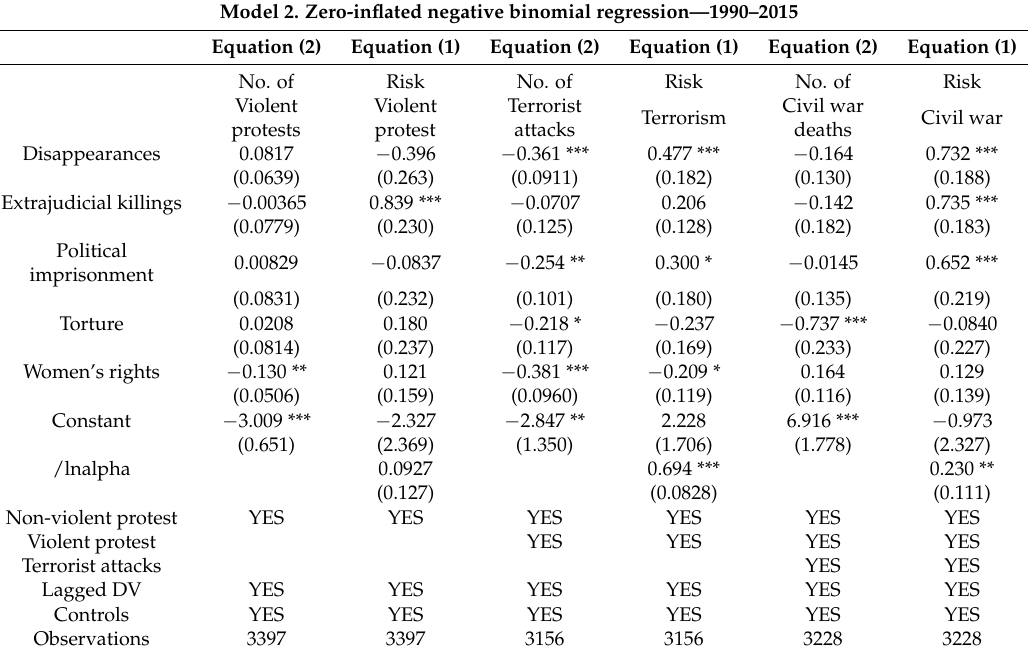
Table 3. Types of Physical Integrity Rights, Women’s Rights and Internal Conflict. Model 2. Zero-inflated negative binomial regression—1990–2015